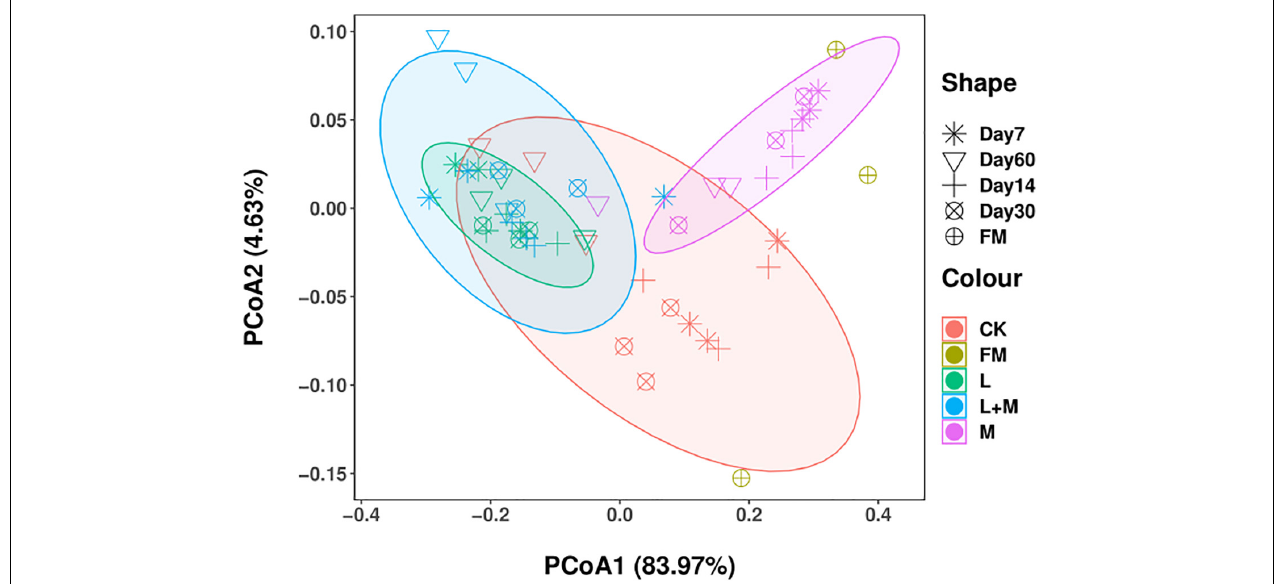
FIGURE 1 | The community dissimilarities in different additives treatments and fermentation time, calculated via weighted UniFrac distances, with coordinates calculated using principal coordinates analysis (PCoA). FM, fresh material; CK, no additive control; L, lactic acid bacteria; M, molasses; L + M, lactic acid bacteria +